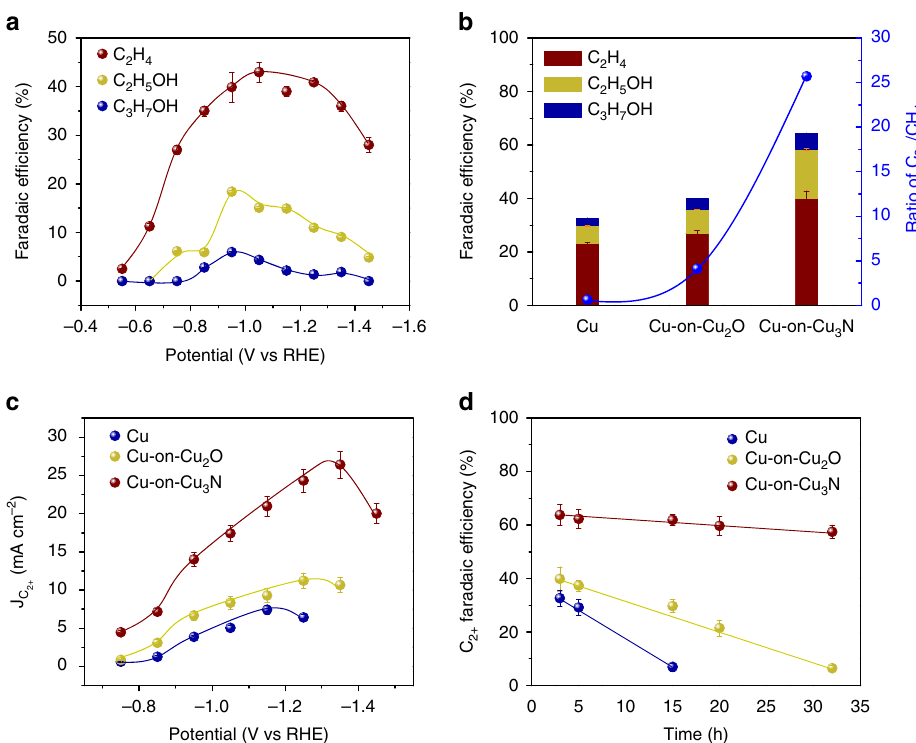
Fig. 4 CO 2 electroreduction performance of the designed catalysts. a Faradaic ef fi ciency of the C 2 + distribution on Cu-on-Cu 3 N at different potentials. b Comparison of faradaic ef fi ciency for C 2 + and the ratio of C 2 + /CH 4 at − 0.95 V vs RHE on Cu, Cu-on-Cu 2 O, and Cu-on-Cu 3 N. c C 2 + partial current density at different potentials on the three catalysts. d Stability test of C 2 + selectivity on the three catalysts. Experiments from a to d were performed in triplicates and the results are shown as mean ± standard